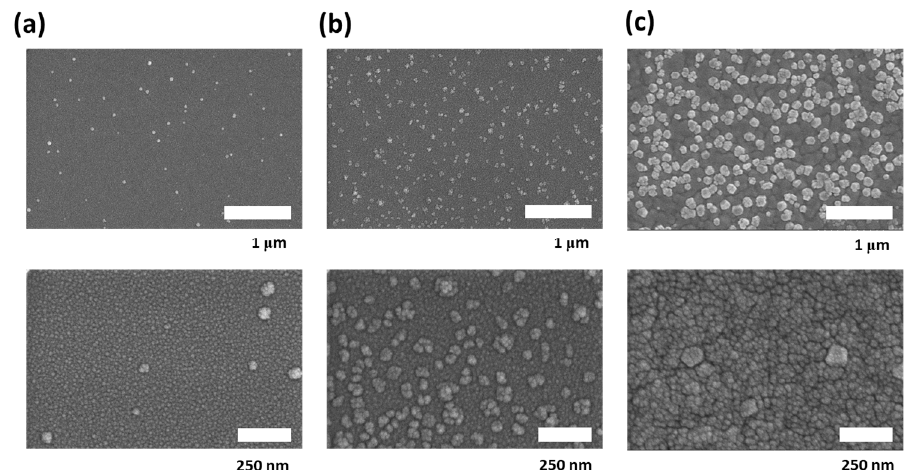
Figure 4. SEM images of the printed ZTO films according to the annealing temperature: ( a ) 300 °C, ( b ) 400 °C, and ( c ) 500 °C (upper: Overall image; lower: Magnified image).